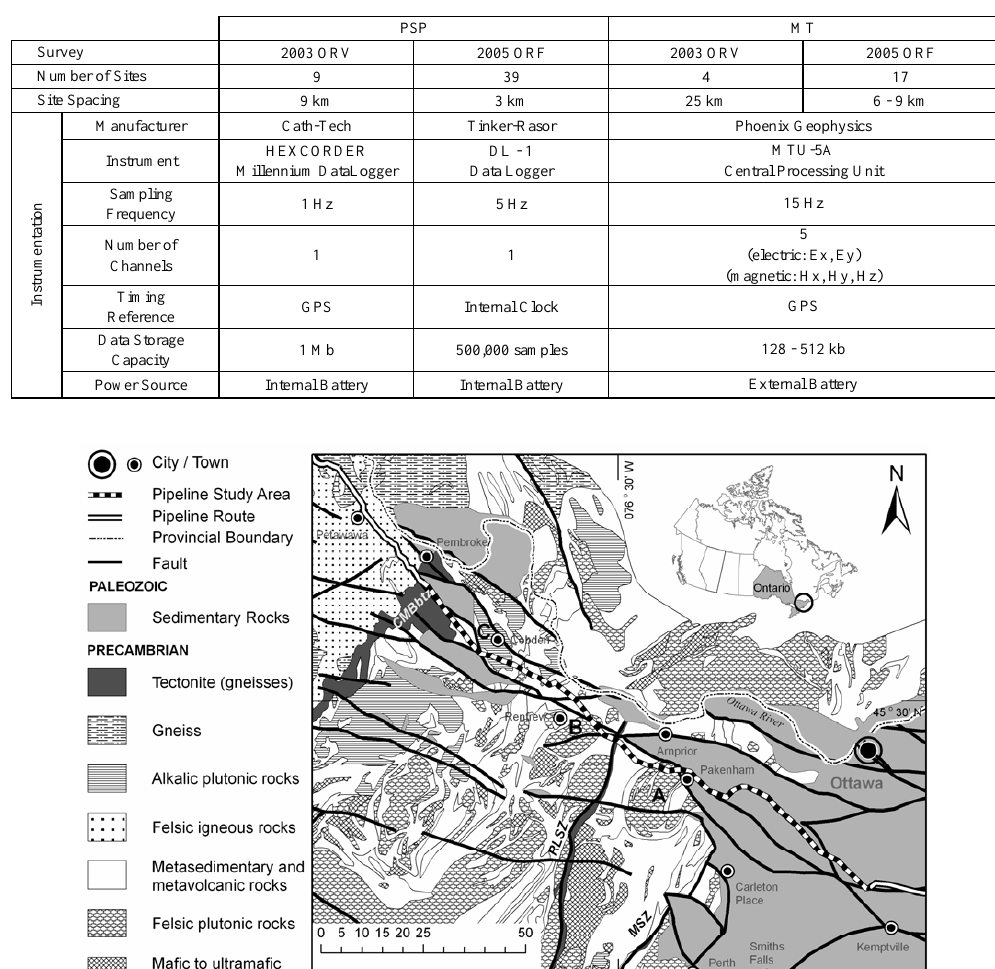
Table 1. Survey statistics and instrument specifications.